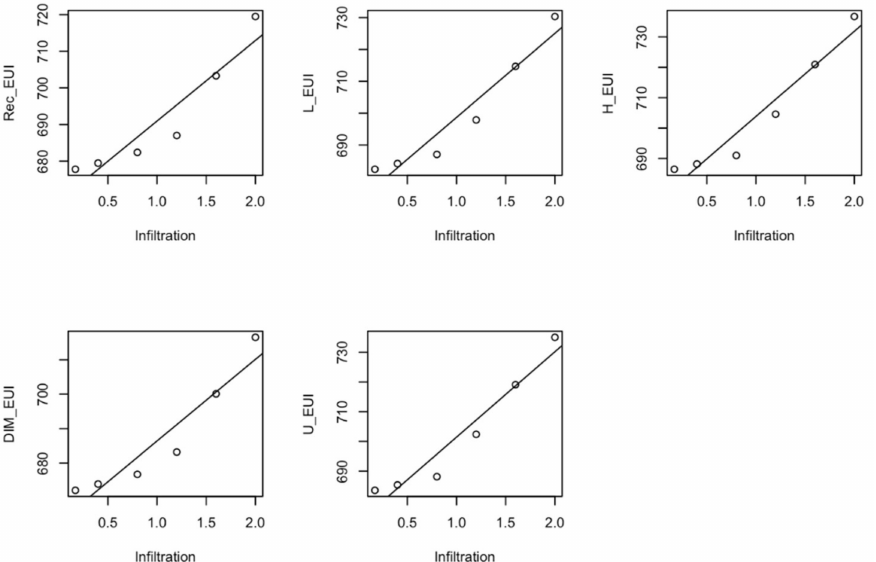
Figure 18. Infiltration fitted line